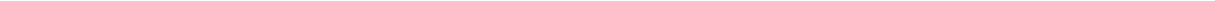
Fig. 4 YAP1 is required for HNSCC survival and proliferation in vitro and in vivo. a Analysis of FAT1 expression in a panel of epithelial cells, including HNSCC. b Expression of CD4ext and CD4-FAT1-TM/ICD chimera in the HNSCC cell line CAL33 by CD4 FACS analysis. c TEAD-Luciferase reporter assay in CAL33 cells transiently transfected with the CD4-FAT1 chimeric constructs. Luciferase expression was evaluated in exponentially growing cultures 36 h after transfection. Bars represent mean Renilla-normalized luciferase expression ± SEM ( N = 4). d Quantitative PCR depicting gene expression levels of the YAP1 transcriptional targets CTFG and CYR61 in CAL33 stably expressing the CD4-FAT1 ICD constructs. Bars represent the GAPDH-normalized mean ± SEM ( N = 3). e In vivo xenograft assay. One million CAL33 cells expressing indicated constructs were injected in nu / nu mice. Data points represent mean volume ( N = 10 tumors per group) ± SEM. f YAP-rescue experiments. In vivo fl ank xenograft assay as in ( e ) using CAL33 expressing CD4-FAT1-TM/ICD and control or the indicated YAP expression vector. Data points represent mean volume ( N = 10 tumors per group) ± SEM. g Spheroid formation assay of stable CAL33 shRNA control and YAP1 shRNA cell lines. Representative pictures are shown on top and diameter quanti fi cations (>200 colonies per group) are shown below. Black lines represent mean ± SEM. h CAL33 stably expressing control and YAP1 shRNAs were stimulated with doxycycline for fi ve days (1 µ g/ml) and then transfected with a 8xTEAD-luciferase reporter. Renilla-normalized reporter activity is expressed as % of control. Bars represent mean ± SEM ( N = 4). i Apoptosis assay by propidium iodide staining of CAL33 cell lines expressing control or YAP1 shRNA after 5d of Doxycycline stimulation. Bars represent mean ± SEM ( N = 4). j In vivo xenograft assay. One million cells were injected in nu/nu mice. Animals were fed Doxycycline food (6 g/Kg) ad libitum 24 h h after tumor cell injection for the duration of the experiment. Data points represent mean volume per group ( N = 10 tumors) ± SEM. k Representative immunohistochemical stainings of CAL33 tumors from panel ( j ). In the Cytokeratin 10 (CK10) panels the dotted red line delimits the proliferating front of the tumor. Scale bar, 100 µ m. l Automated histological quanti fi cation of stainings in ( k ), bars represent mean ± SEM ( N = 3). ** P < 0.01, *** P < 0.001 (One-way